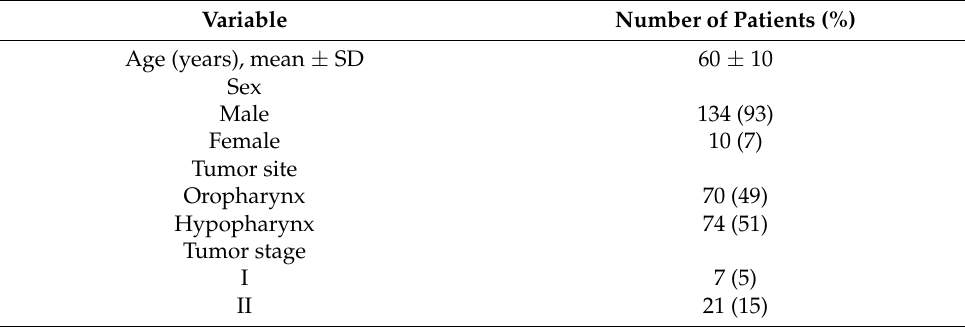
Table 2. General characteristics of the study participants ( n =